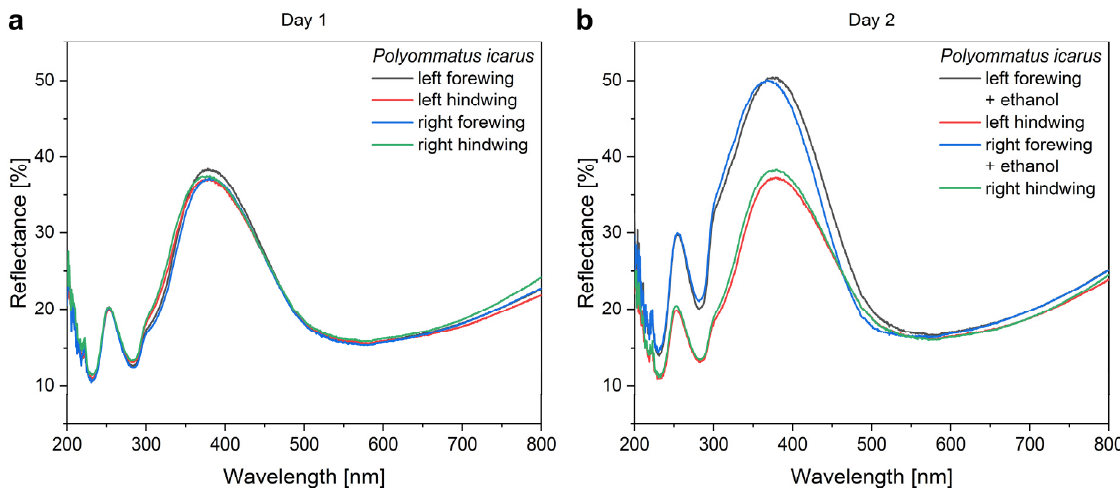
Figure 3. The effect of ethanol pretreatment and the reproducibility of the spectral measurements exemplified by the four wings of the same butterfly. ( a ) The reflectances of the four glass mounted wings measured before the ethanol pretreatment are shown, while in ( b ), the spectra of the same four wings, remeasured next day, are shown after two of the wings have undergone the ethanol pretreatment.